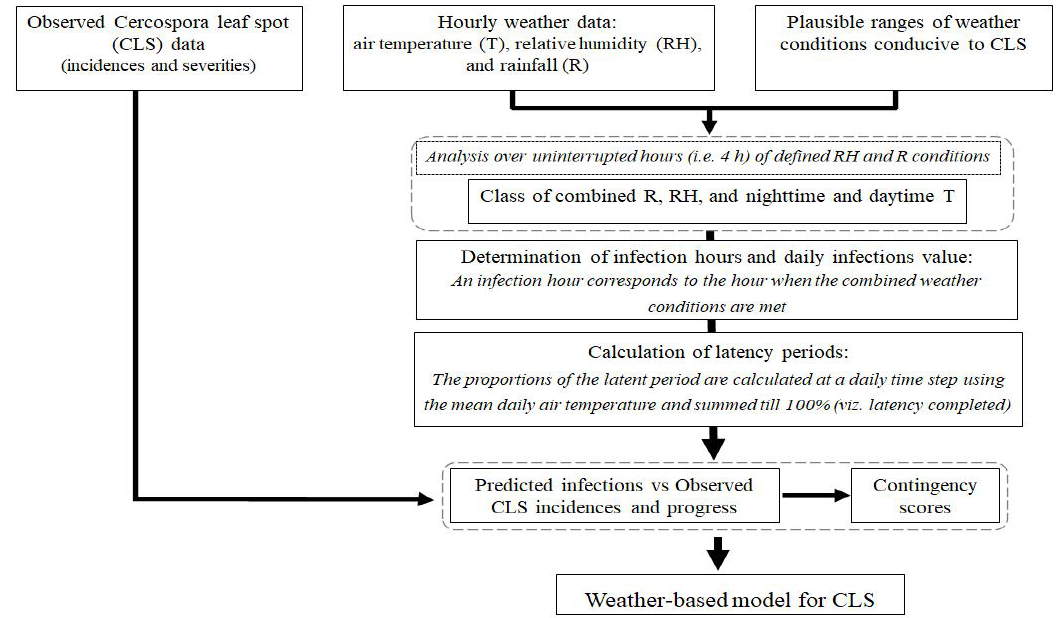
Figure 2. Flowchart describing the modelling approach used for predicting infection events of sugar beet by Cercospora beticola .